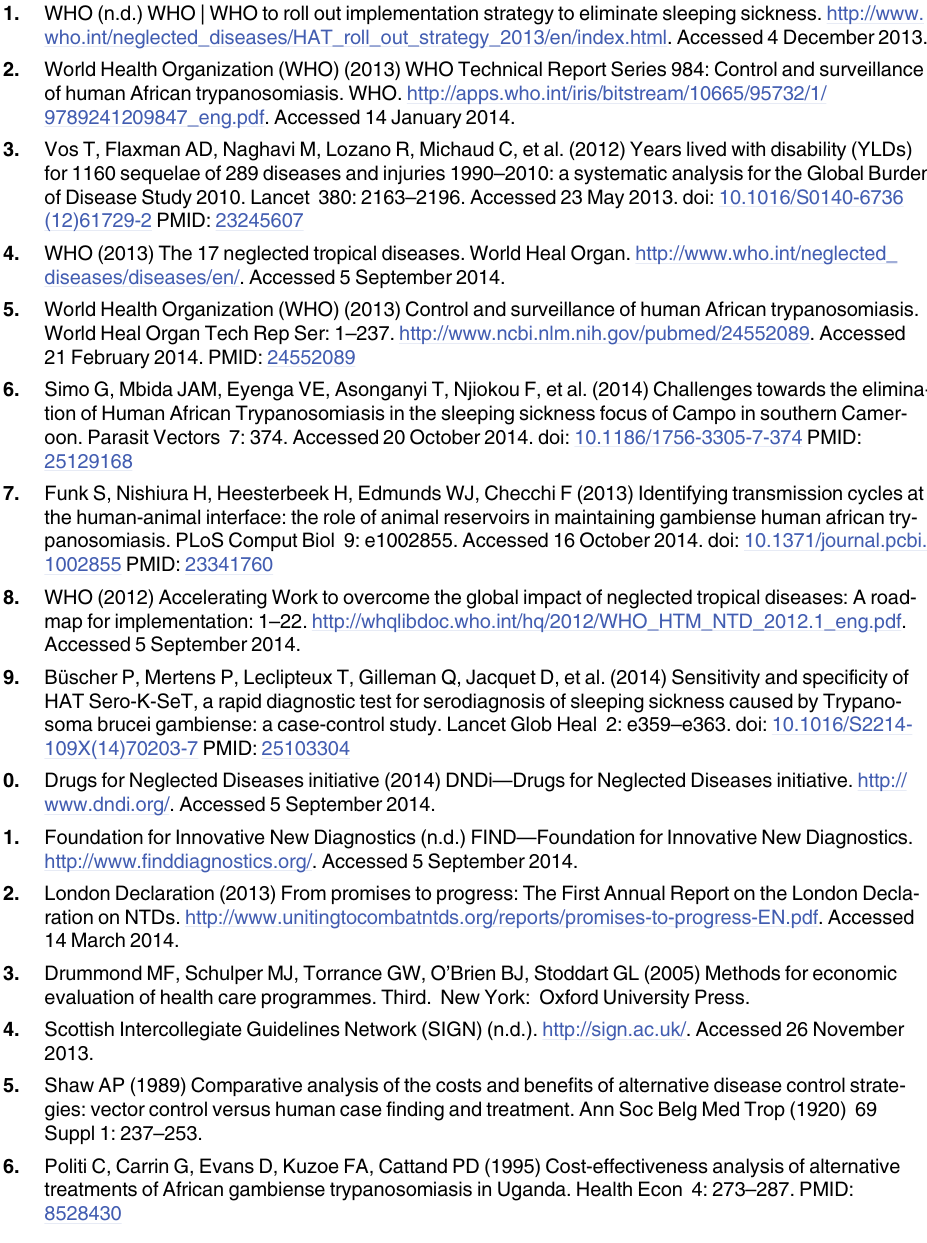
S2 Supporting Information. Inclusion-exclusion criteria legend. Abbreviations: LYG, life- years gained; HRQoL, health-related quality of life; BIA, budget impact analysis; BOI,